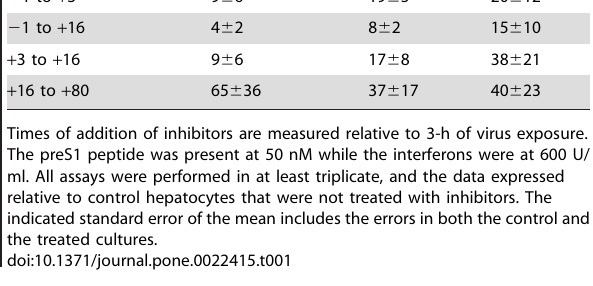
indicated standard error of the mean includes the errors in both the control and the treated